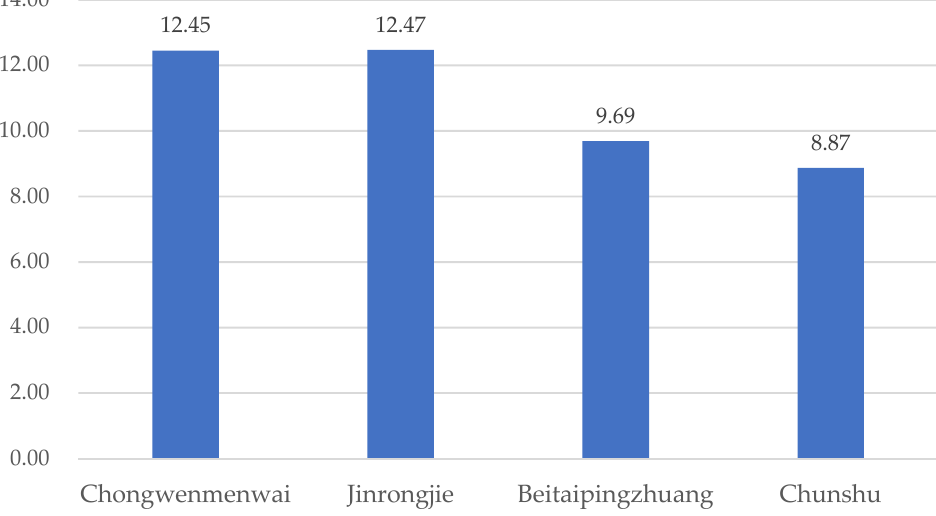
Figure 16. The public space lighting comfort results of four typical residential areas. It can be seen from the comfort results of four typical residential areas that Chongwen-